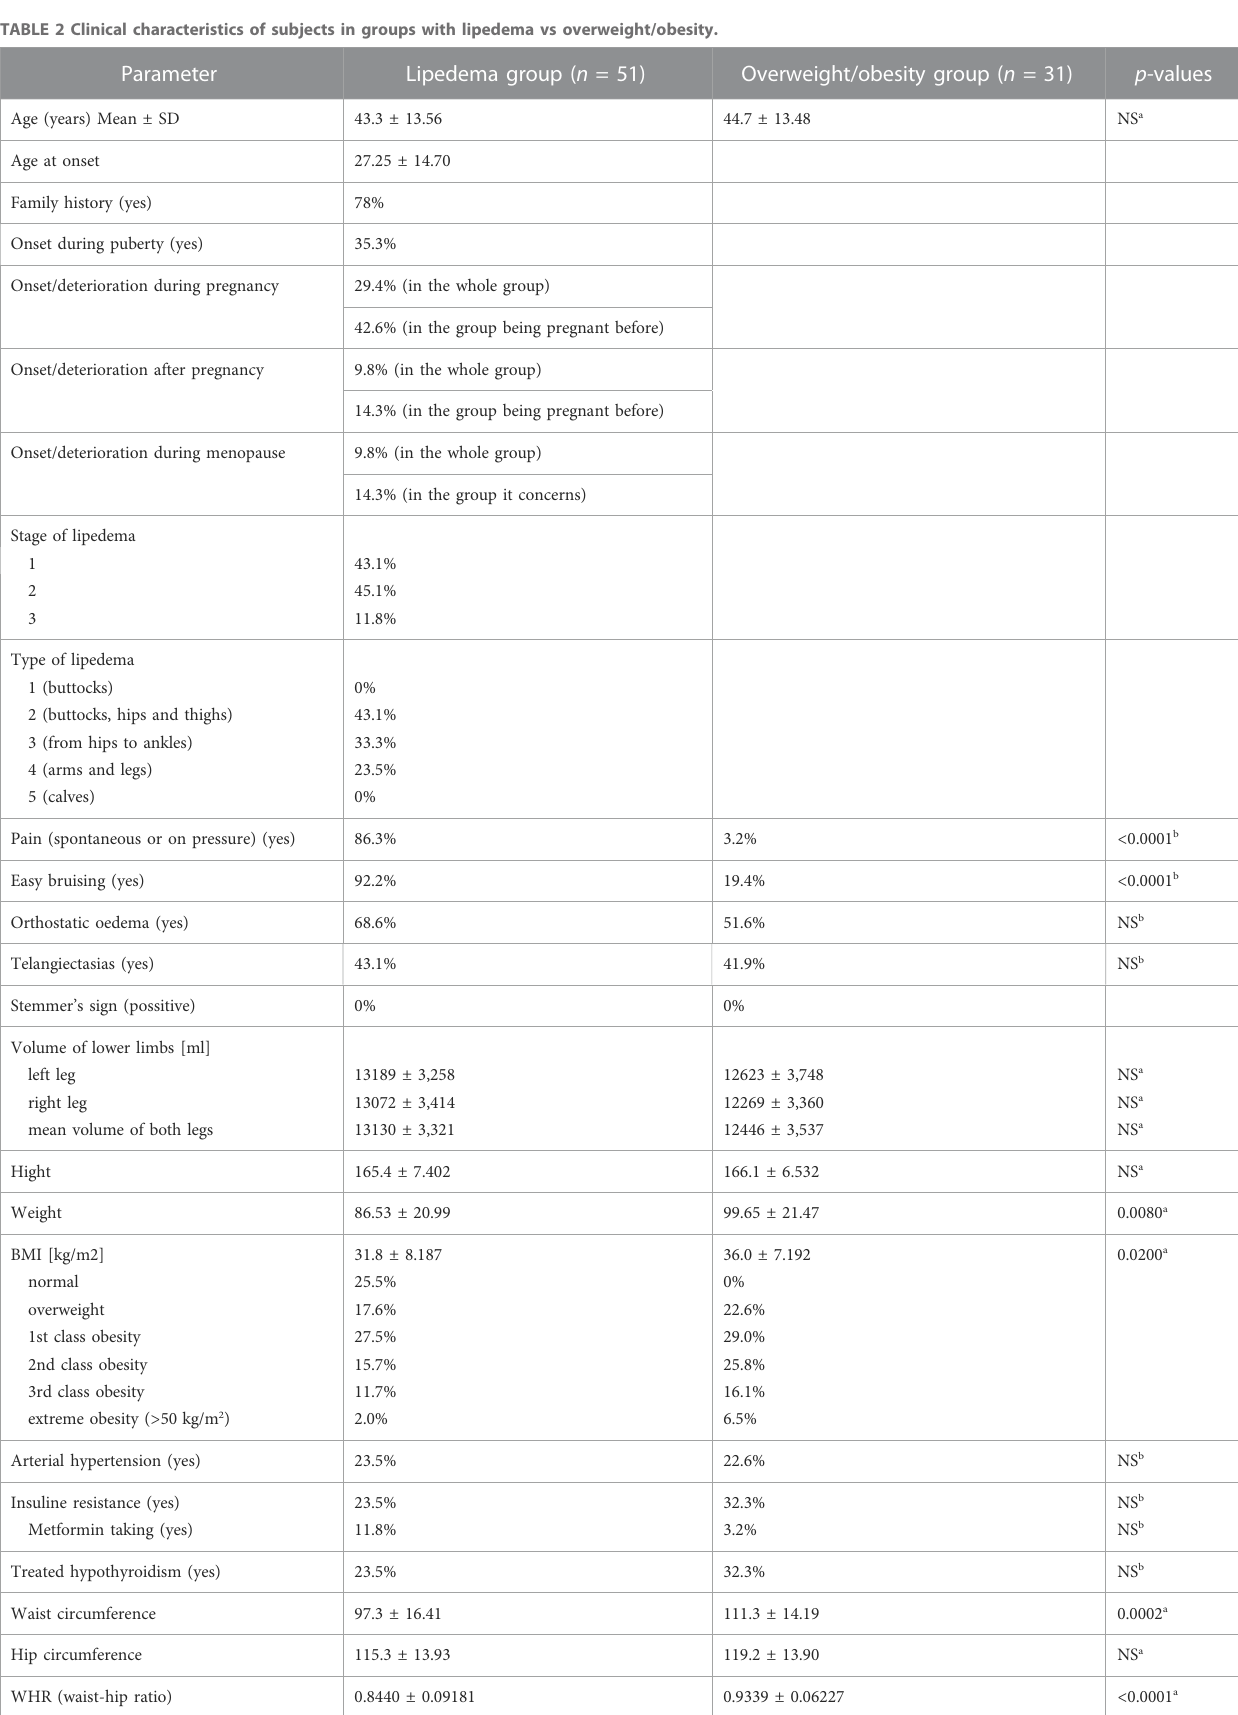
TABLE 2 Clinical characteristics of subjects in groups with lipedema vs